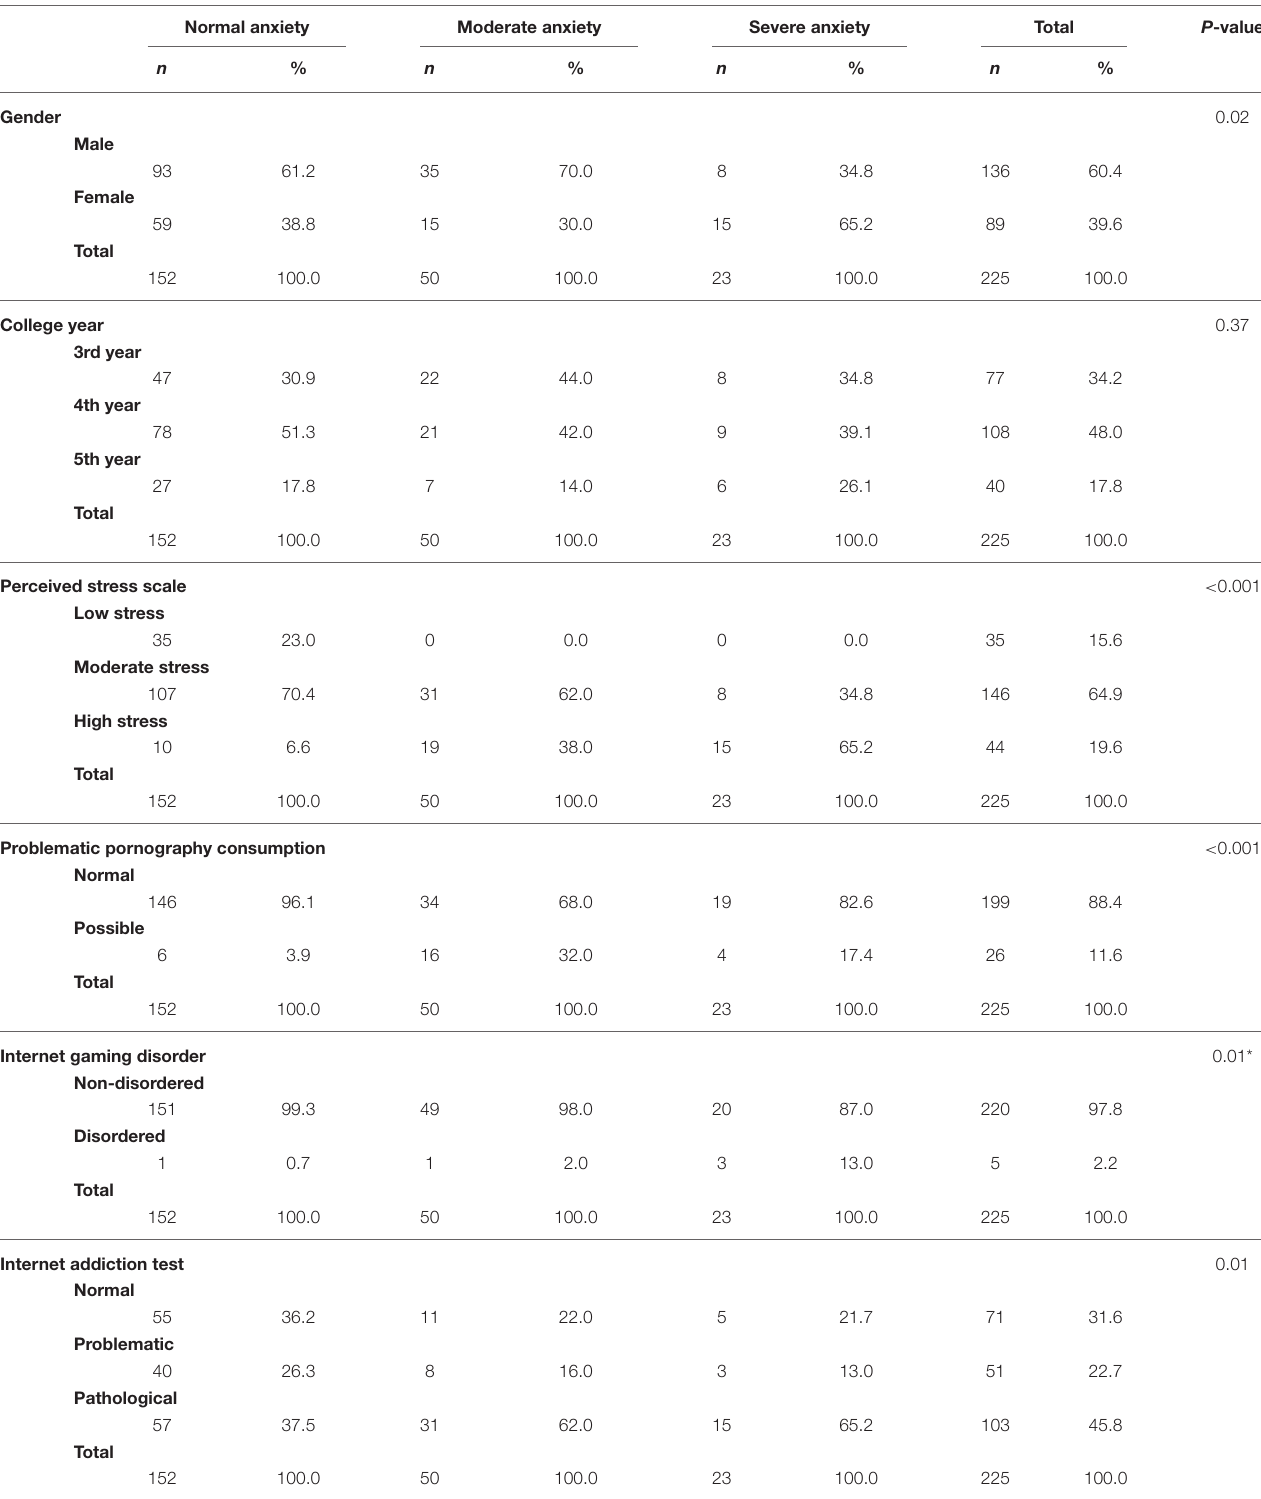
TABLE 4 | Association between different behavioral addictions and anxiety. Normal anxiety Moderate anxiety Severe anxiety